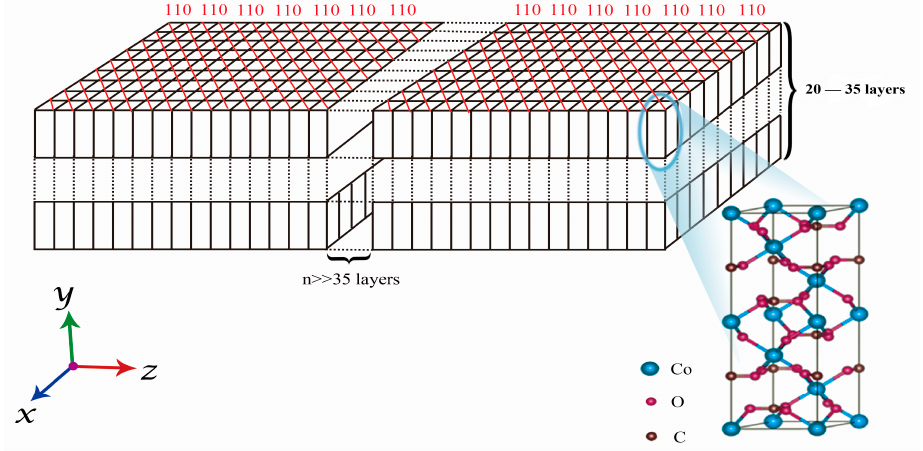
Figure 8. Growth diagram of the primary particle in three dimensions.